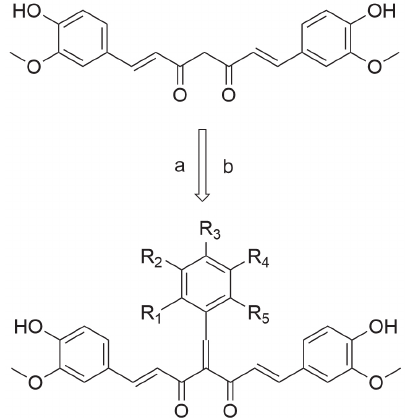
FIGURE 3 - Reaction scheme: Synthesis of Knoevenagel condensates of curcumin. Reagents and conditions: